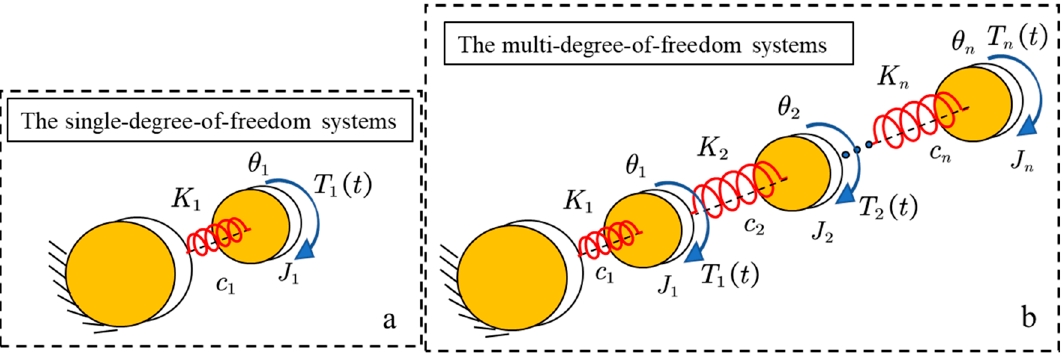
Figure 5. Simplification Model. ( a ) the single-degree-of-freedom; ( b ) the multi-degree-of-freedom.